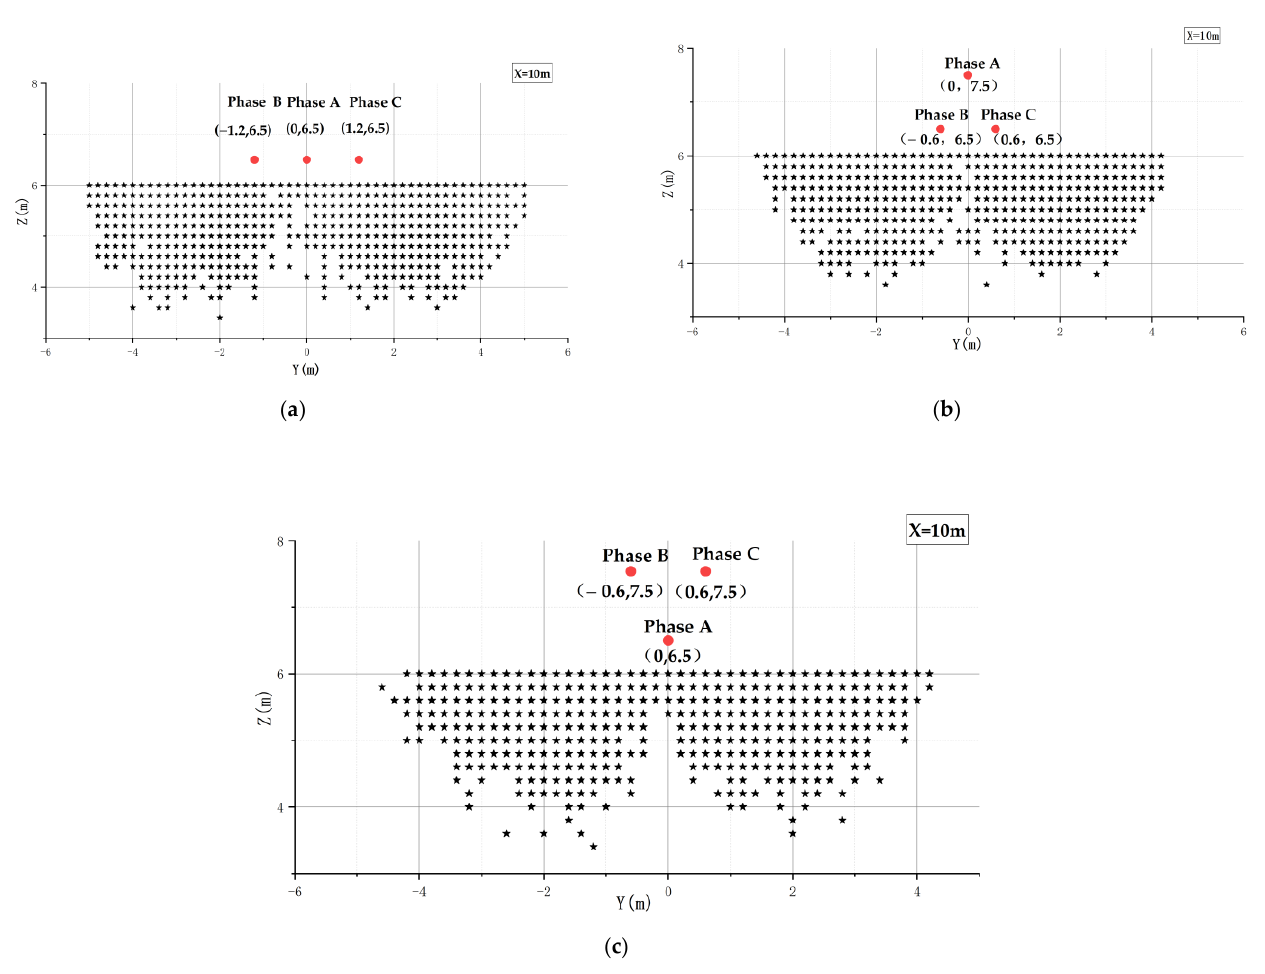
Figure 21. Sensor array measurement range diagram for different arrangements: ( a ) Horizontal arrangement; ( b ) Triangular arrangement; ( c ) Inverted triangular arrangement.